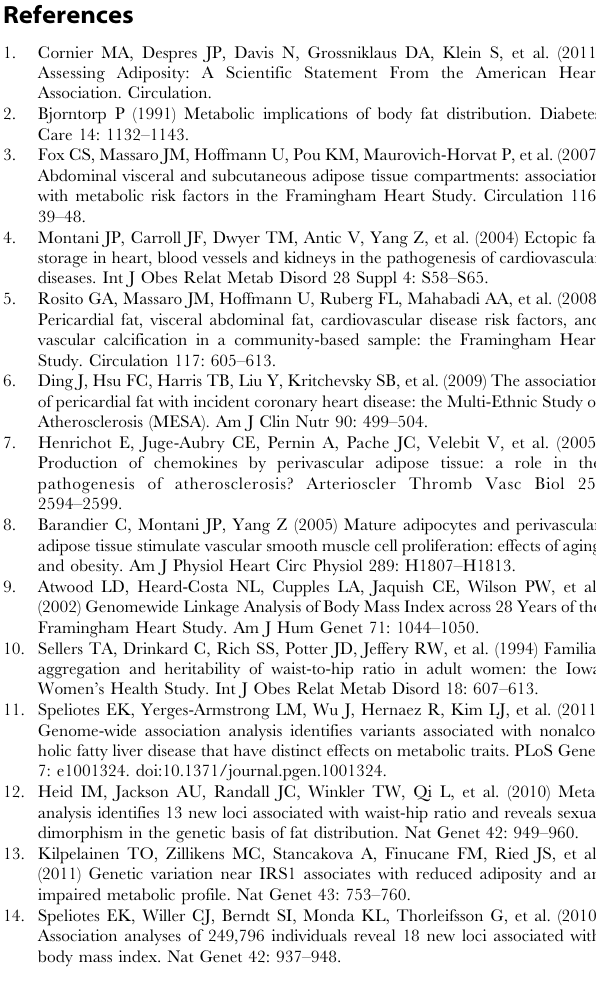
Table S2 All SNPs with p-value , 1E-04. Z-scores presented modeled per copy of Alelle1. Table S3 Look-up of all validated Coronary Heart Disease SNPs as identified and validated by the CARDIoGRAM consortium with Pericardial Fat. Statistical significance derived from 25 independent tests (0.05/25= 0.002). Table S4 Look-up of SNPs from a Recently Published GWAS of Body Fat Distribution* (Heid IM et al, NG, 2010) [12]. All data modeled relative to the GIANT trait-increasing allele. Table S5 Association of validated SNPs for BMI (from Speliotes et al, Nature Genetics 2010) [14]. All data modeled with the same coded allele in GIANT, and modeled relative to the GIANT trait- increasing